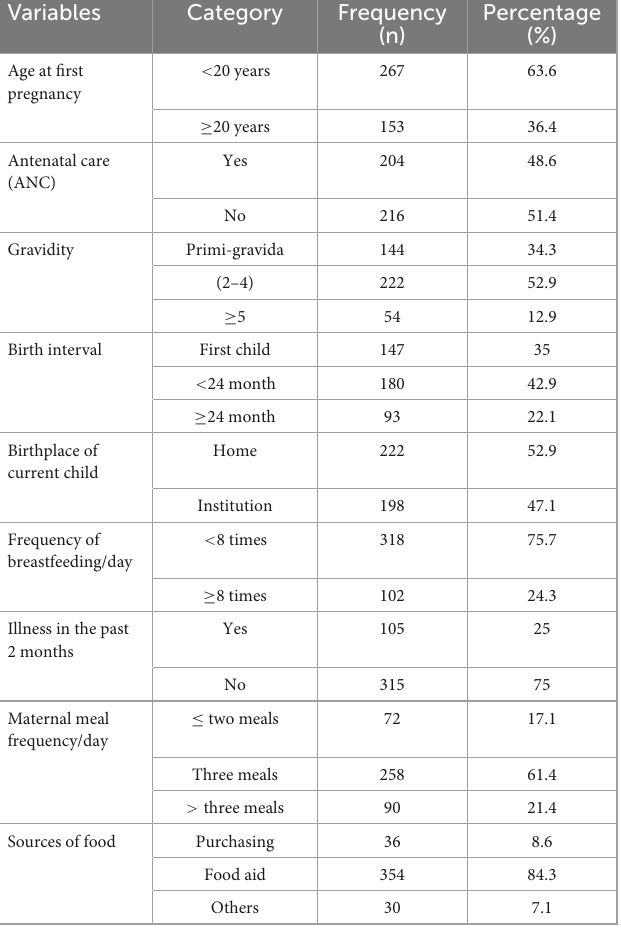
( Table 6 ). Based on the principle of the logistic regression model, we used techniques like the normative category, the smallest value, and the category whose mean is in the middle to choose the reference category